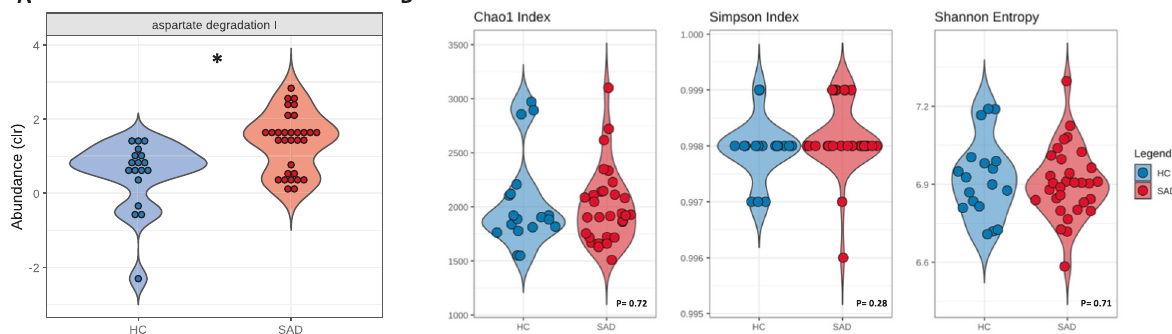
Fig. 3 Functional differences between SAD and control groups. A One gut metabolic module, Aspartate Degradation I, was found to be increased in SAD patients. B Functional diversity, between SAD and healthy controls, as measured by Chao1, Simpson and Shannon indices. p values based on Student ’ s t-test. No differences seen between the groups. (* p = <0.05) (Clr centred log-ratio transformed, HC Healthy Control, SAD Social Anxiety